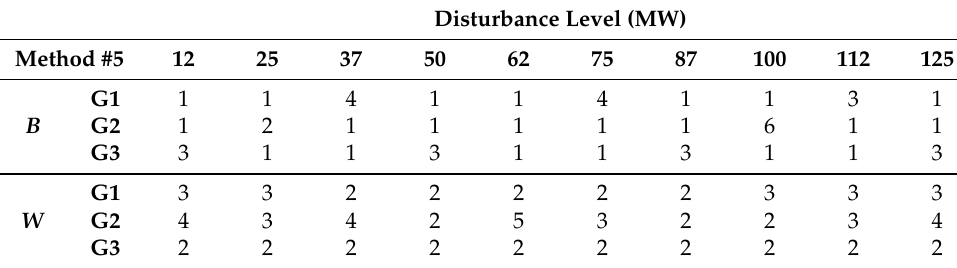
Table 9. Optimal W and B values under different disturbance